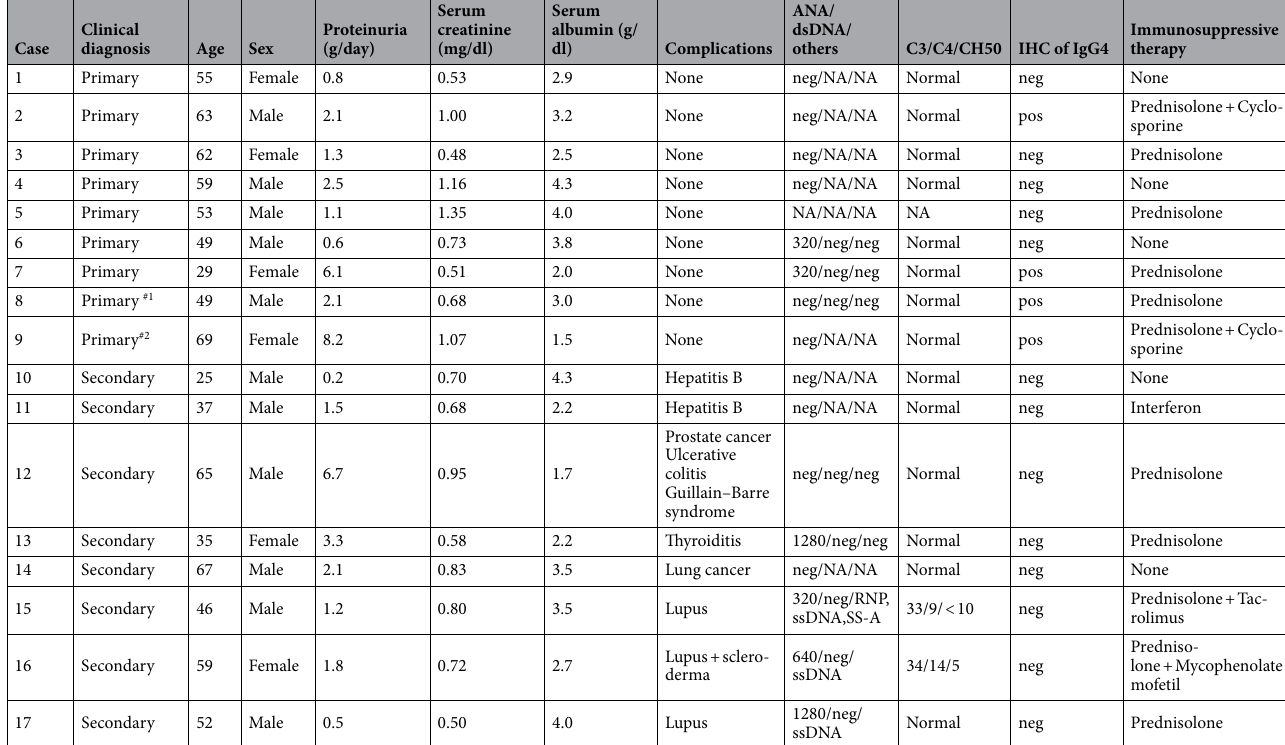
Table 4. Clinical information in each case of Ext1/Ext2–associated MN. ANA antinuclear antibody, neg negative, pos positive, NA not available, ssDNA single strand DNA, dsDNA double strand DNA, #1 enhanced staining of PLA2R was also found, #2 enhanced staining of THSD7A was also